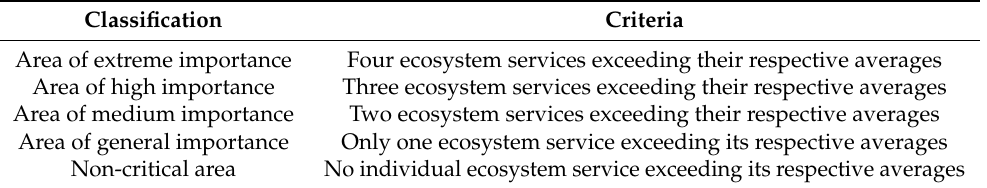
Table 2. The importance grades of multiple ESs. Classification Criteria Area of extreme importance Four ecosystem services exceeding their respective averages Area of high importance Three ecosystem services exceeding their respective averages Area of medium importance Two ecosystem services exceeding their respective averages Area of general importance Only one ecosystem service exceeding its respective averages Non-critical area No individual ecosystem service exceeding its respective